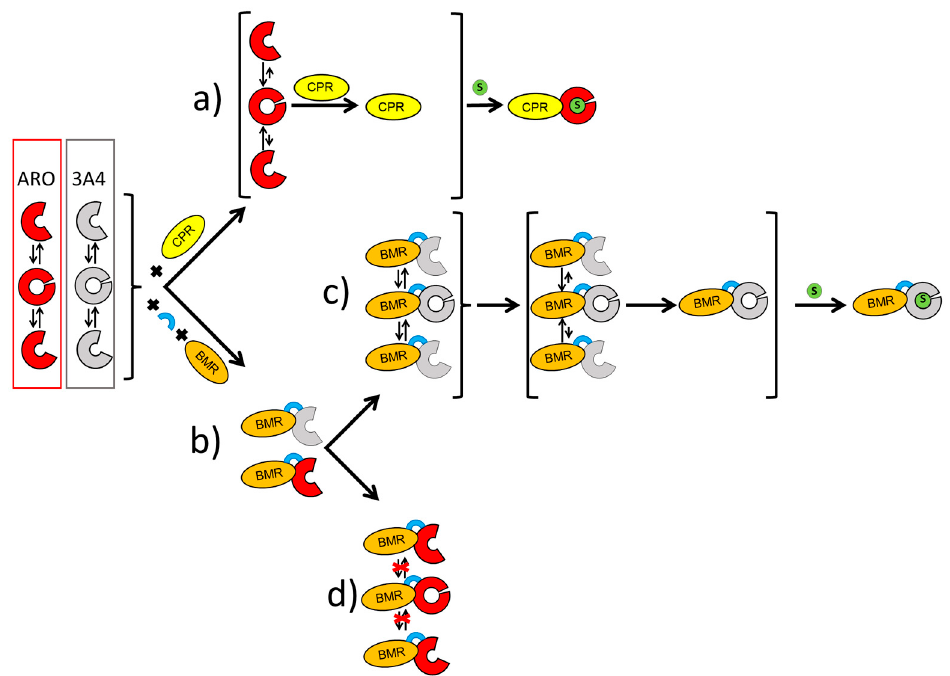
Figure 5. Effect of the molecular Lego on different CYPs P450. ( a ) Aromatase explores different conformational states and CPR is a positive effector in facilitating the pursuit of the optimal conformation for substrate binding [45]. ( b ) 3A4-BMR or ARO-BMR chimeras. ( c ) 3A4-BMR is able to perform the conformational transitions required for optimal substrate binding ( d ) BMR, although interacting with ARO as demonstrated by DSC data, is not able to allow the required conformational transitions that are necessary for optimal substrate binding in ARO.